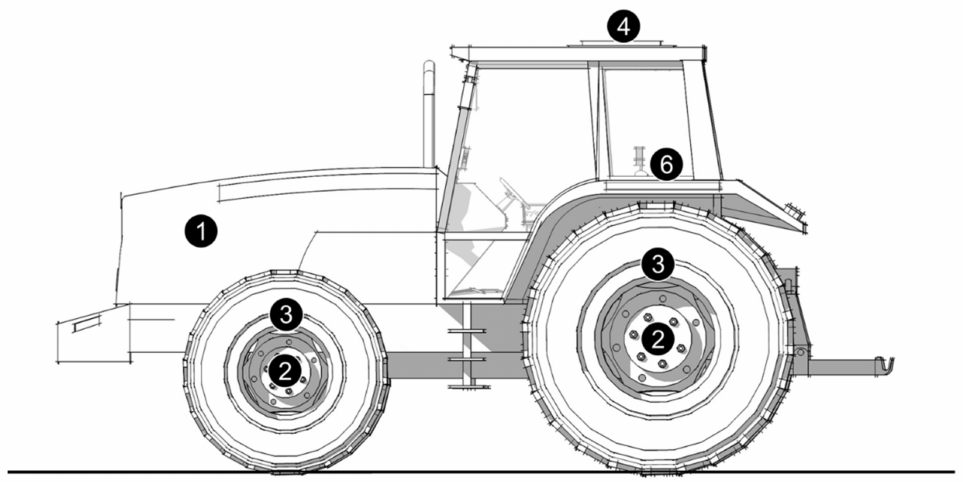
Figure 1. Load measurement system installed at each measurement position on the